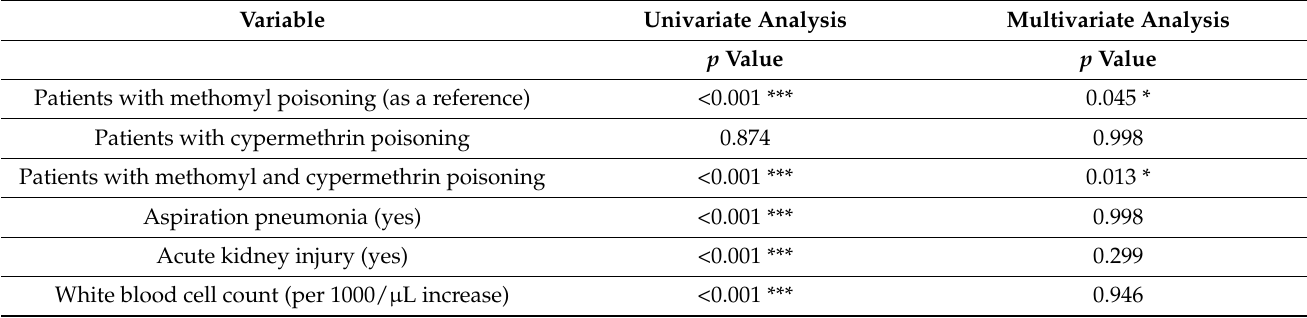
Table 5. Analysis of acute respiratory failure using a multivariate logistic regression model (n =